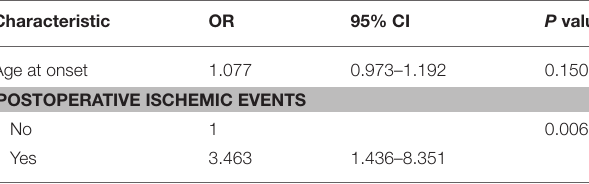
TABLE 4 | Univariate logistic regression analysis for predictive factors of unfavorable surgical outcome. Characteristic